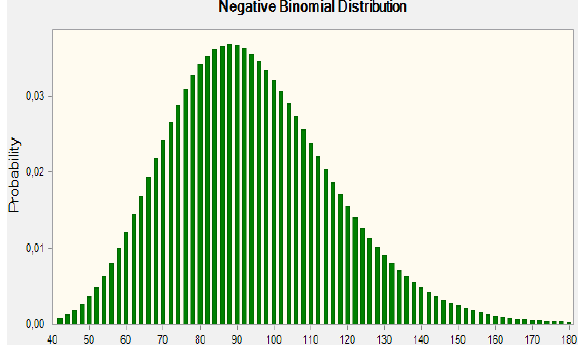
Figure 5. Probability of distribution of rental prices for a standard double-room in Bratislava. Table 5. Descriptive statistics of probability distribution for rent prices of a standard double-room in Bratislava.